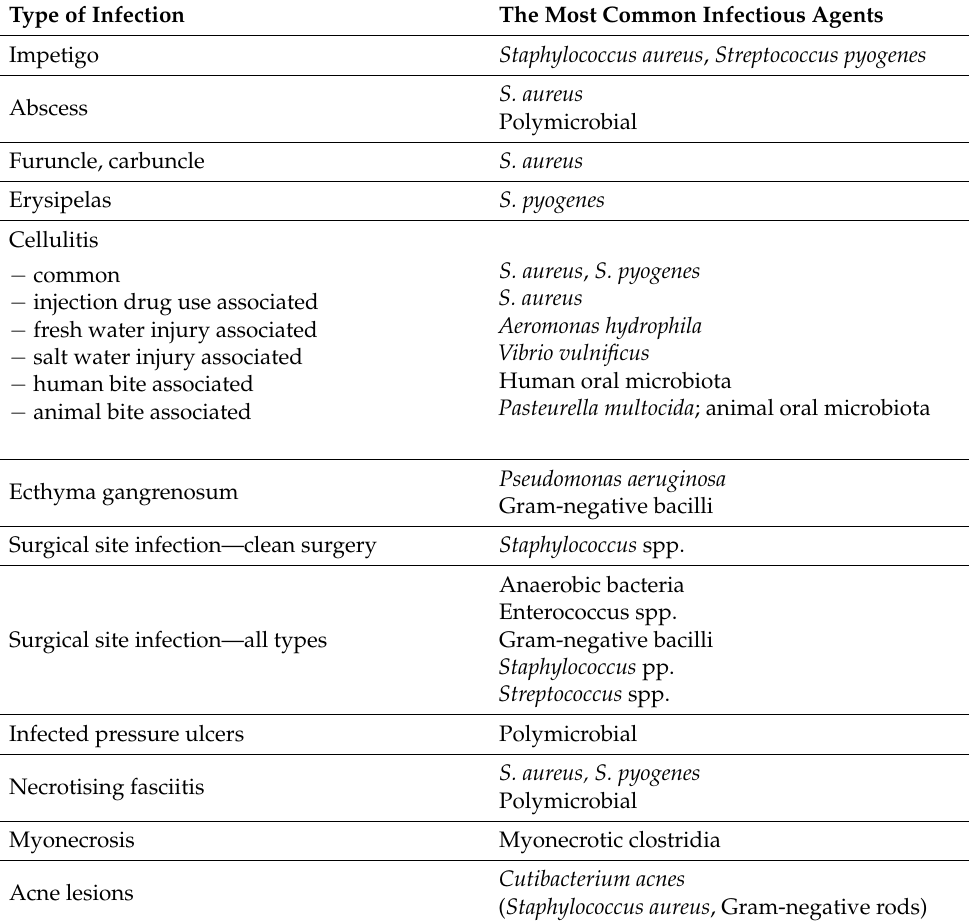
Table 1. The most frequent and most important skin and soft tissue infections